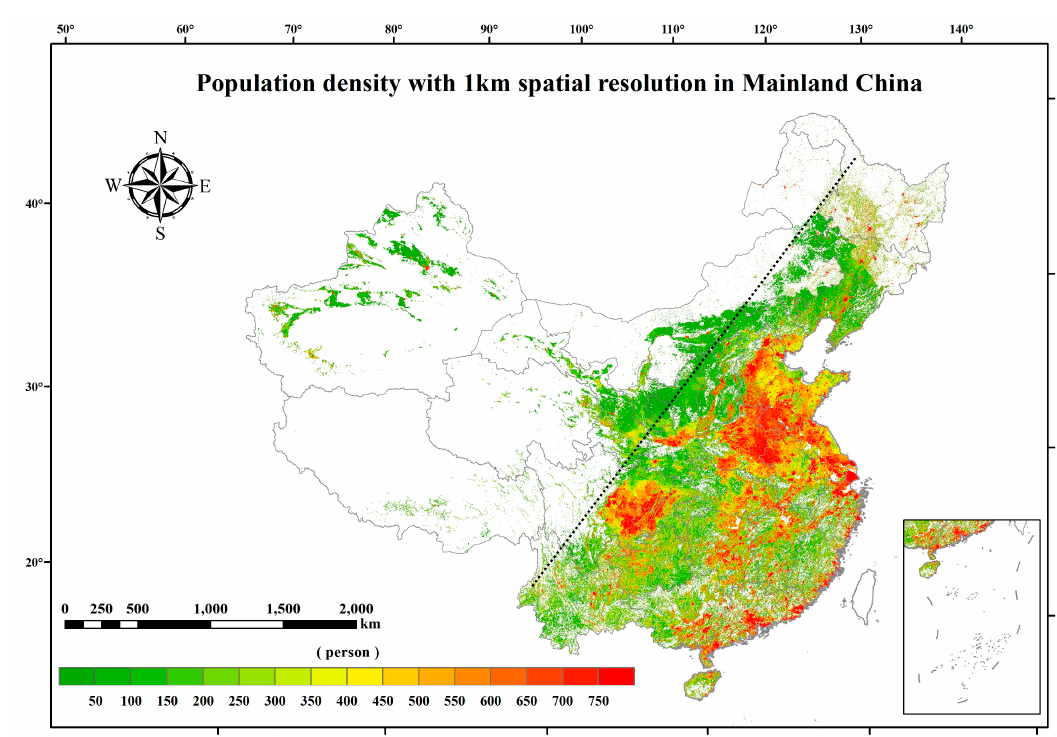
Figure 2. Gridded population density in mainland China in 2014 with a spatial resolution of 1 km. The black dotted line represents the “Heihe-Tengchong Line”.